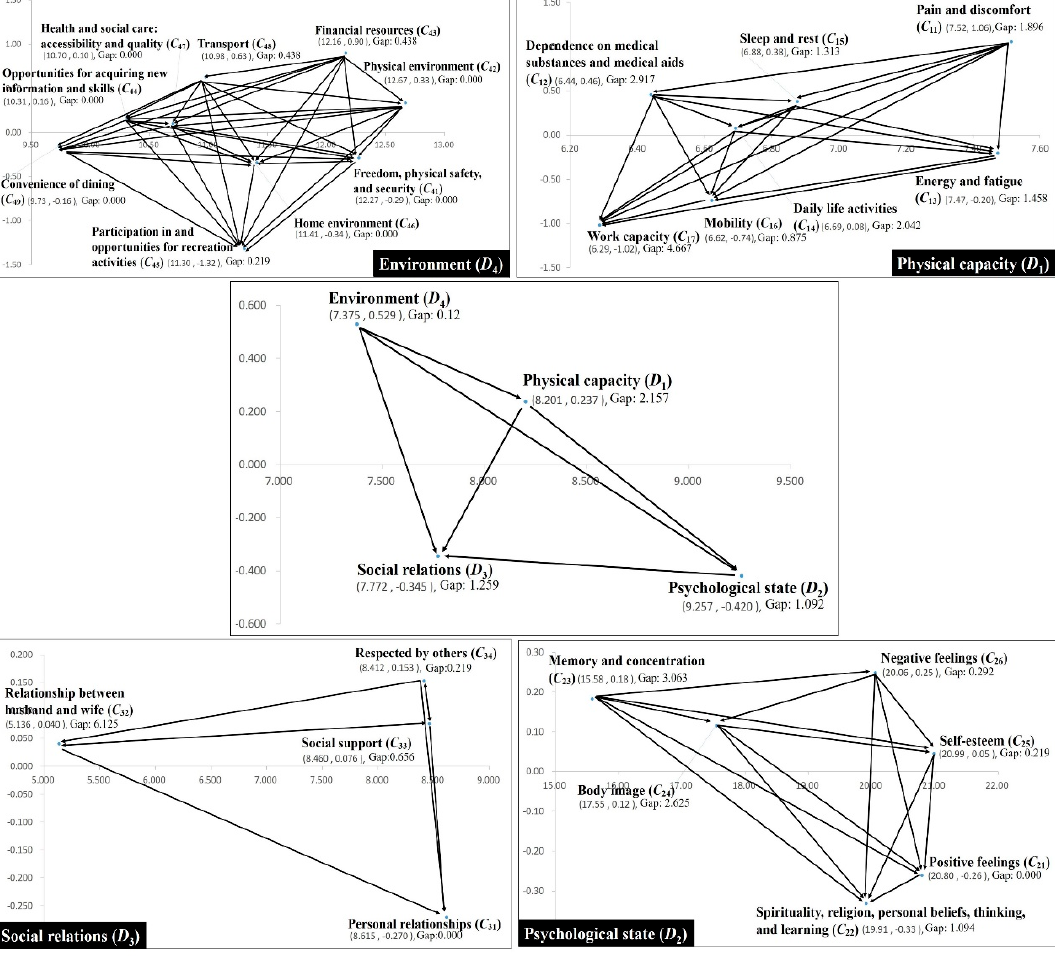
Figure 4. Overall INRM (influential network relation map).